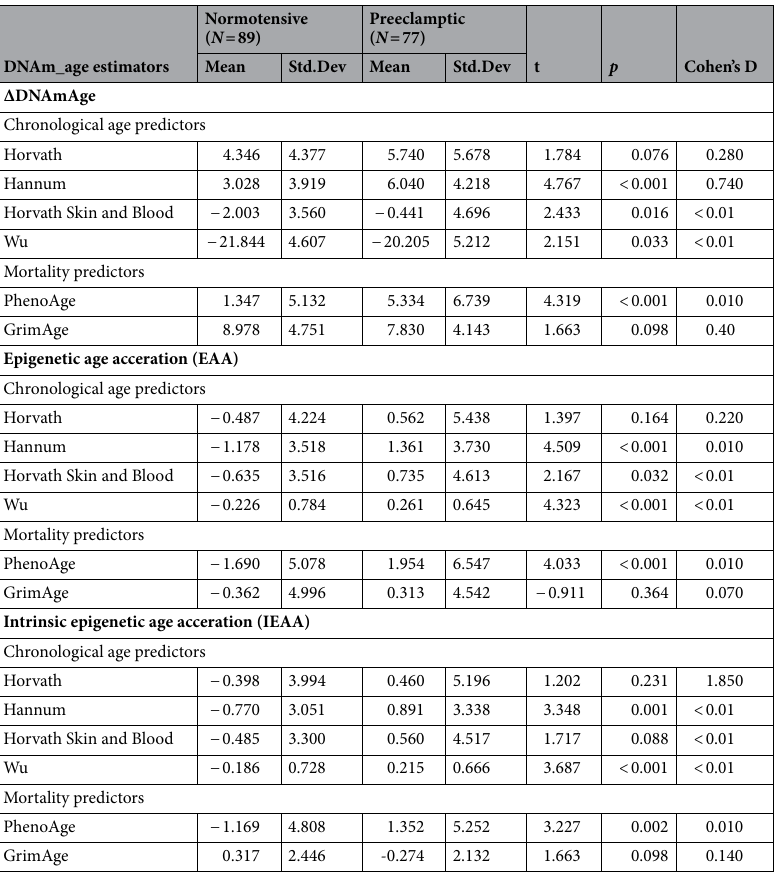
Table 3. Independent t-tests between average accelerated mDNA age estimators among investigated women: ΔDNAmAge – the difference between DNA methylation and chronological age, EAA- Epigenetic Age Acceration IEAA—the intrinsic epigenetic age